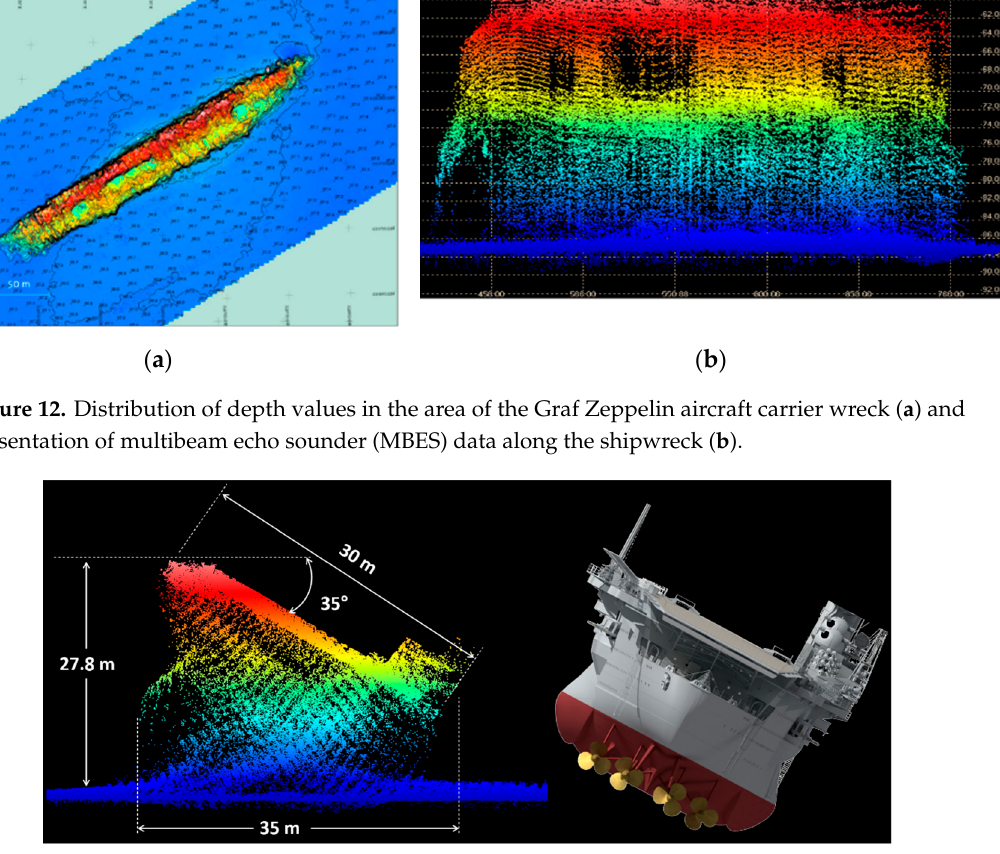
Figure 13. The swath view of wreck derived from MBES data.